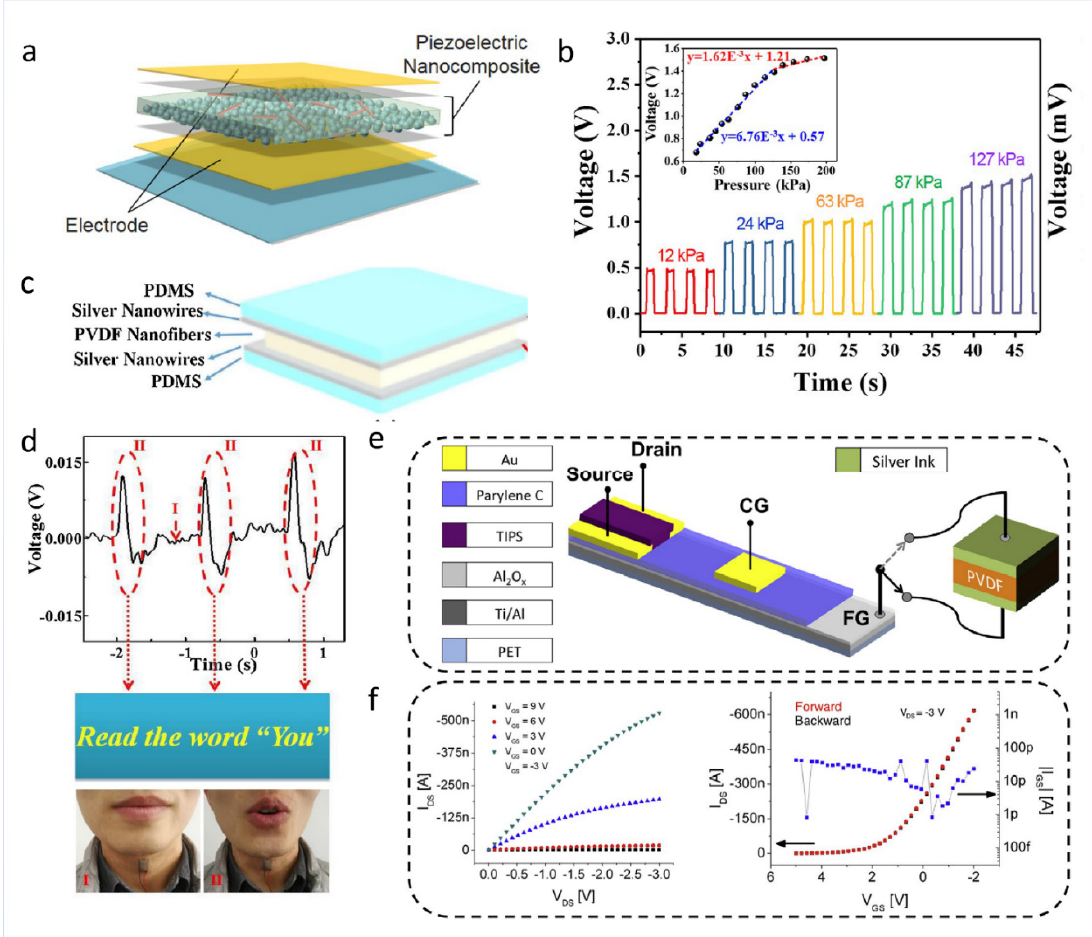
Figure 5. ( a ) The schematic illustration of the fabricated 0 – 3 carbon nanotubes (CNTs)-doped ceramic epoxy piezoelectric nanocomposite film. ( b ) The pressure response of the nanocomposite sensor with 0.07 wt% CNTs under pressure range from 0 to 200 kPa [75]. Copyright 2018, Elsevier. ( c ) Schematic diagram of pressure signal detection of the flexible pressure sensor. ( d ) Open-circuit voltage of the sensor when attached to the vocal cords [38]. Copyright 2018, Elsevier. ( e ) Structure and employed materials of the PVDF-based tactile sensor. ( f ) Output and input properties of the device for pressure sensing [79]. Copyright 2016, Elsevier.